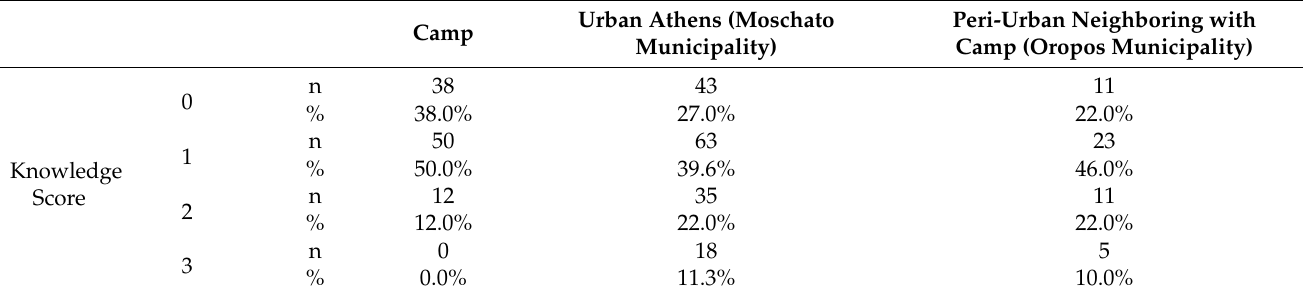
Table 3. Knowledge score: correct answers to Knowledge